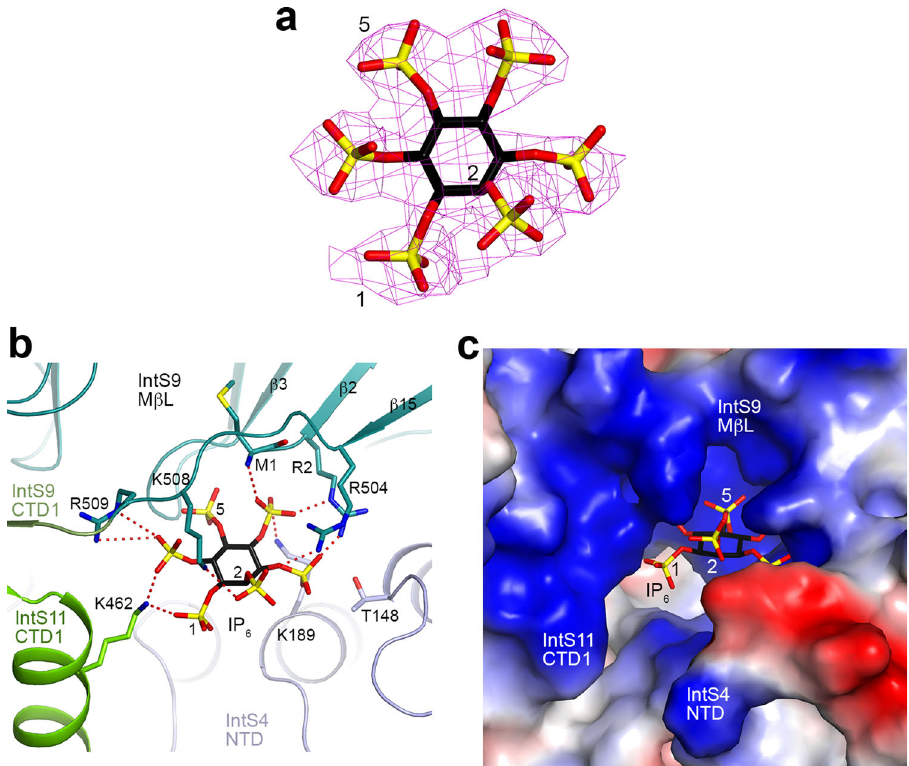
Fig.4|DetailedinteractionsbetweenIP 6 andthe Drosophila IntS4-IntS9-IntS11 complex (ICM). a Cryo-EM density for IP 6 . The axial, 2-position is labeled. b Detailed interactions between IP 6 and the ICM. Ionic interactions between the